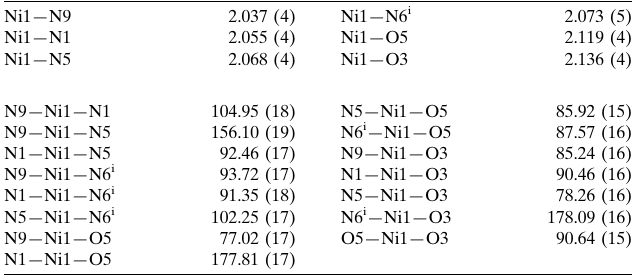
Selected geometric parameters (A˚ , (cid:2) ).